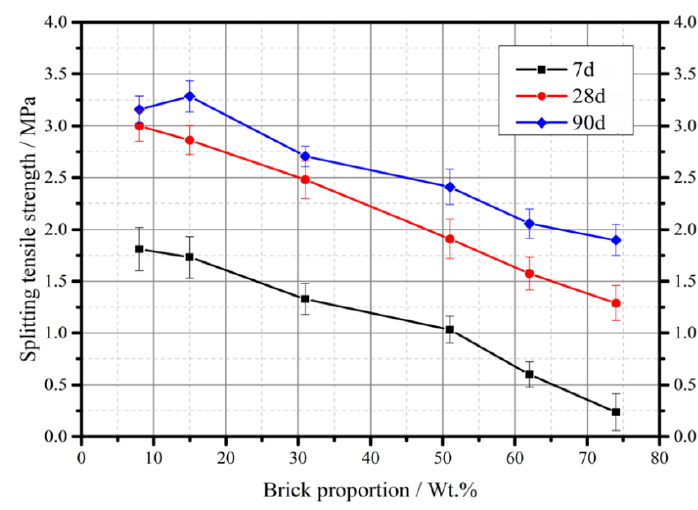
Figure 20. Splitting tensile test of concrete mixture with di ff erent brick proportion of recycled materials.